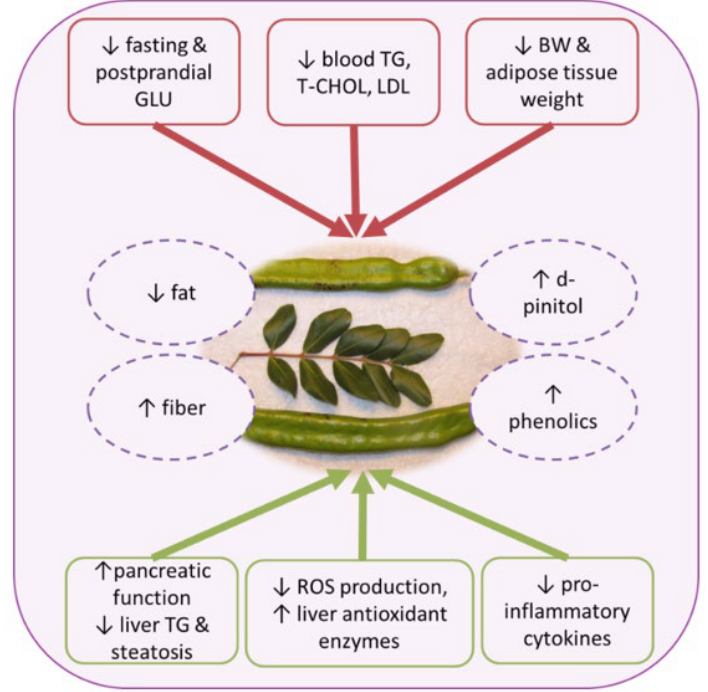
Figure 3. Effects of carobs on metabolic health. GLU, glucose; TG, triacylglycerols; T-CHOL, total cholesterol; LDL, low-density lipoprotein; ROS, reactive oxygen species; BW, body weight.